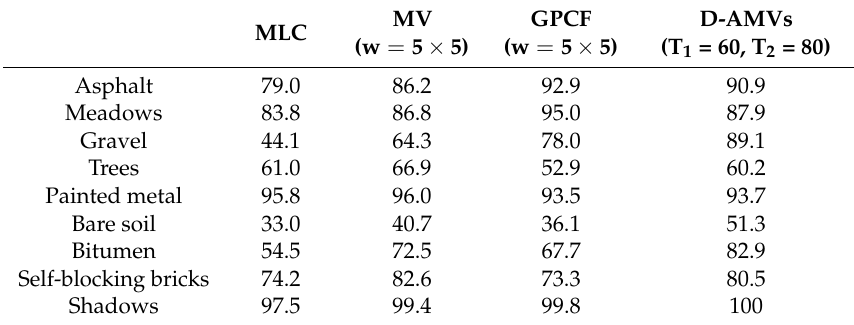
Table 5. Class-specific user accuracy (%) of the Pavia University image for the different